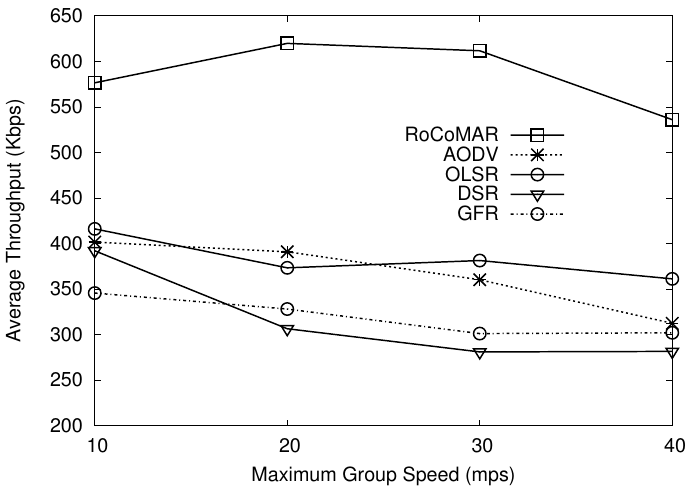
Figure 7. Effects of node mobility on average